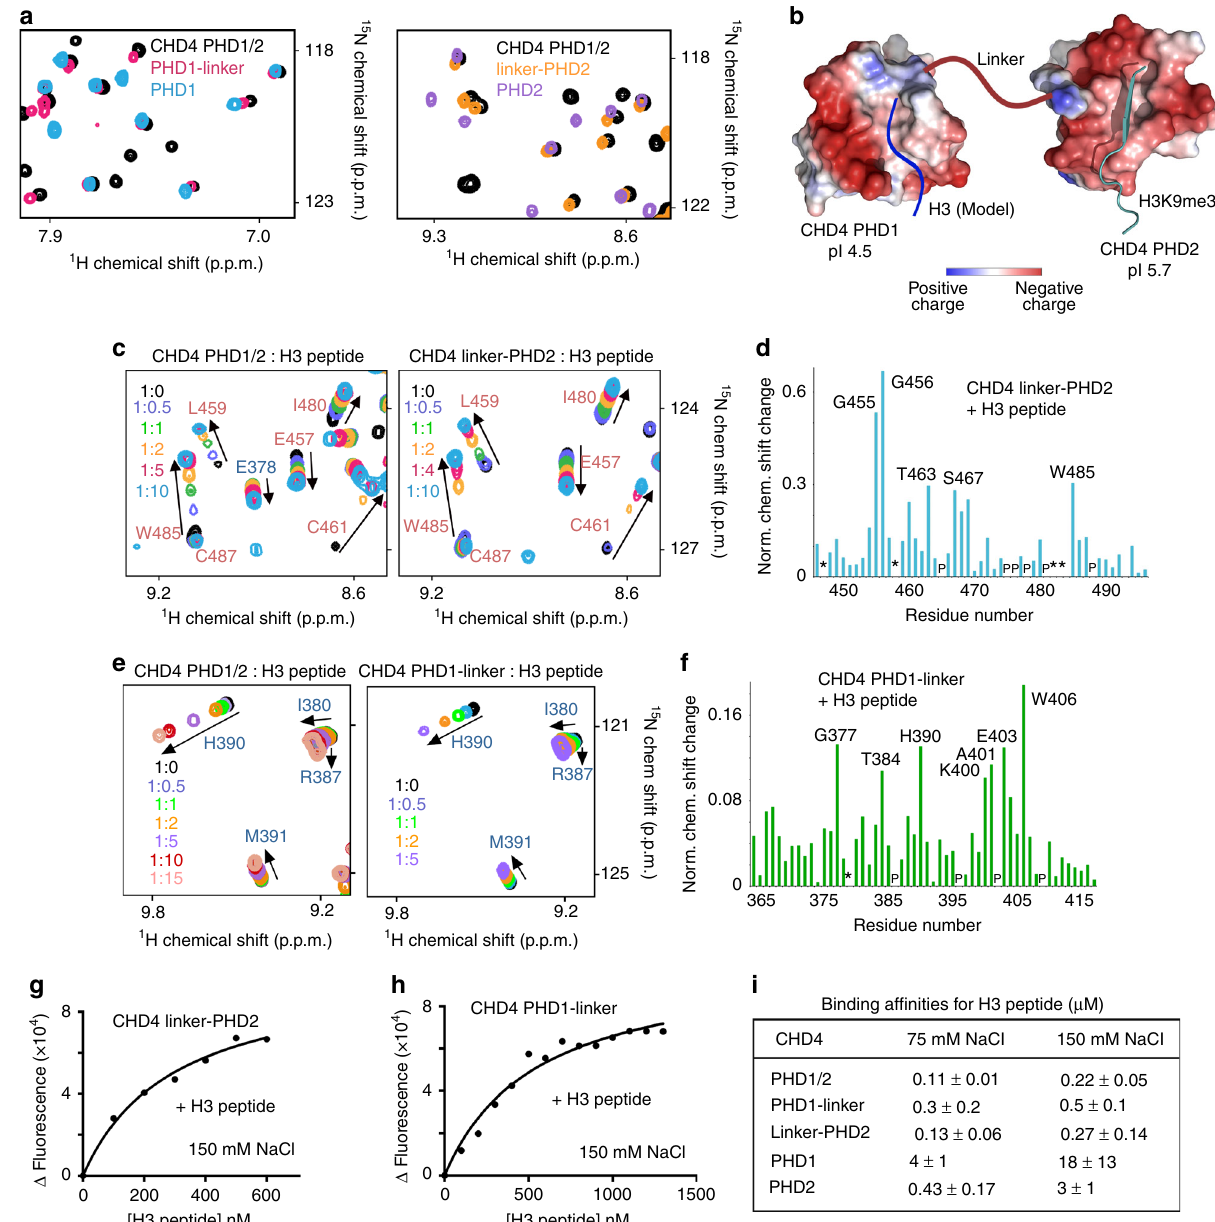
Fig. 3 The linker affects histone binding of PHDs. a Superimposed 1 H, 15 N HSQC spectra of CHD4 PHD1, PHD1-linker, and PHD1/2 (left) or CHD4 PHD2, linker-PHD2, and PHD1/2 (right). b The inter-domain organization of CHD4 PHD1/2. Electrostatic surface potential of PHD1 and PHD2 in complex with H3K9me3 peptide (PDB IDs: 2L5U and 2L75). Blue and red colors represent positive and negative charges, respectively. c Superimposed 1 H, 15 N HSQC spectra of PHD1/2 or linker-PHD2 collected upon titration with histone H3 (1 – 12) peptide. d The histogram shows normalized 1 H, 15 N chemical shift changes induced by the peptide in linker-PHD2. e Superimposed 1 H, 15 N HSQC spectra of either PHD1/2 or PHD1-linker collected upon titration with peptide. g , h Representative binding curves used to determine the K d values for CHD4 linker-PHD2 and PHD1-linker by tryptophan fl uorescence. Three (PHD1-linker) or four (linker-PHD2) separate runs were performed to obtain SD. i Binding af fi nities of CHD4 PHDs to H3 (1 – 12) peptide as measured by fl uorescence spectroscopy in buffer containing 75 mM NaCl or 150 mM NaCl. Error is SD based on three or four separate